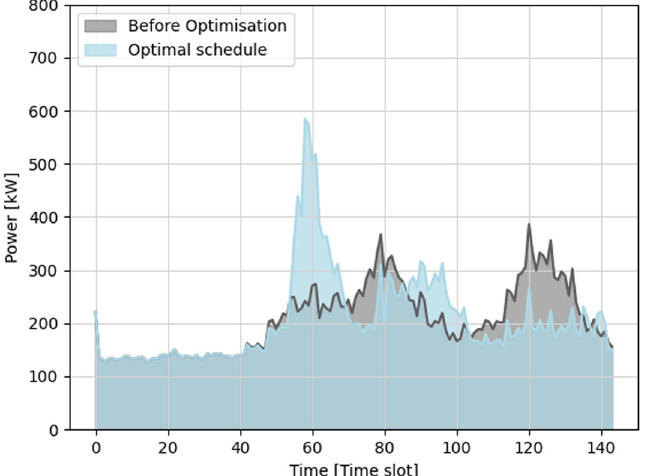
Fig. 8 Example of optimal scheduling for 2000 households in Case study 1 with ± 5 h of shift